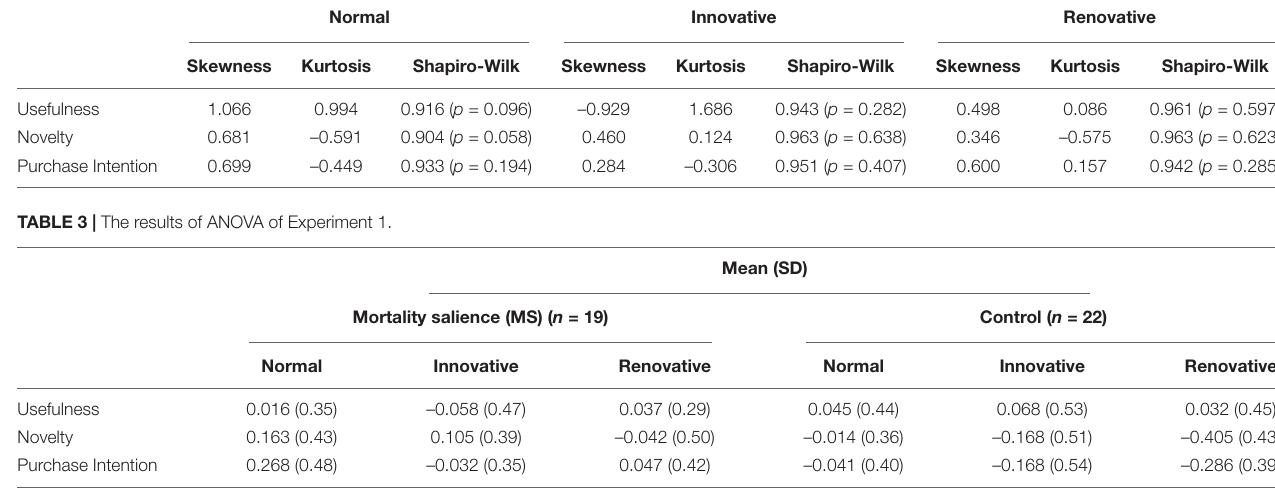
TABLE 2 | In Experiment 1, the measurements of kurtosis and skewness as well as the W -test on the dependent variables (the differences in the evaluation scores between pre-test and post-test, (cid:52) M = M post − M pre ). Normal